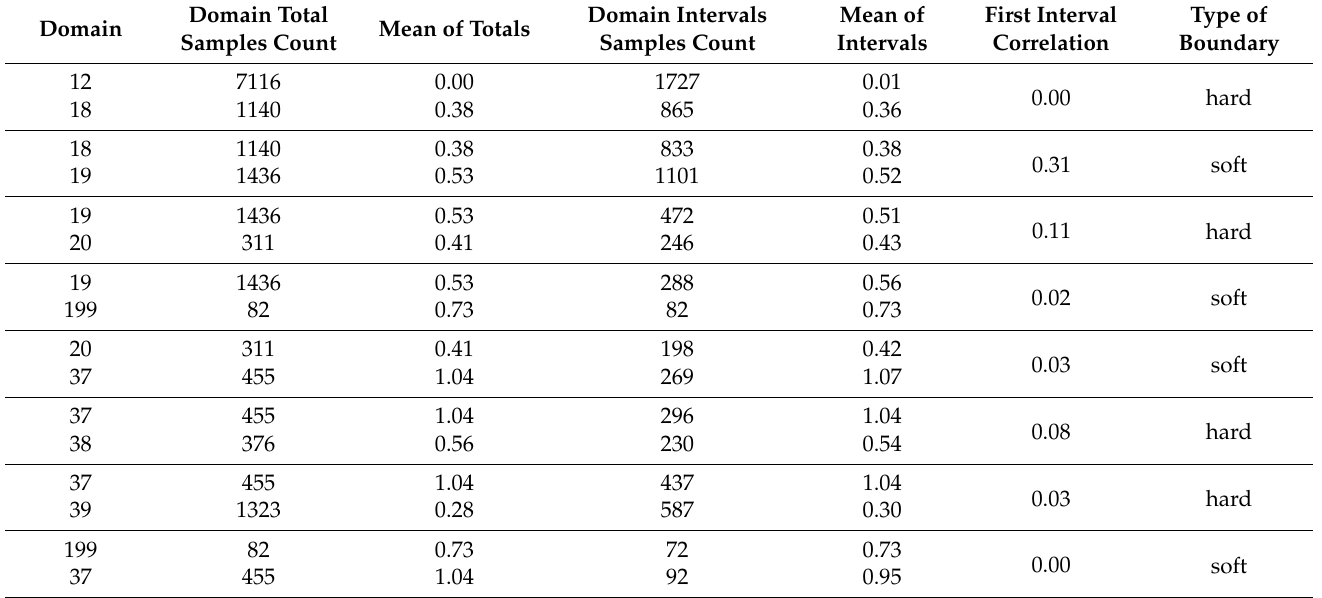
Table 1. Basic statistics of Ni samples near the interfaces between neighbouring domains and first interval correlation.